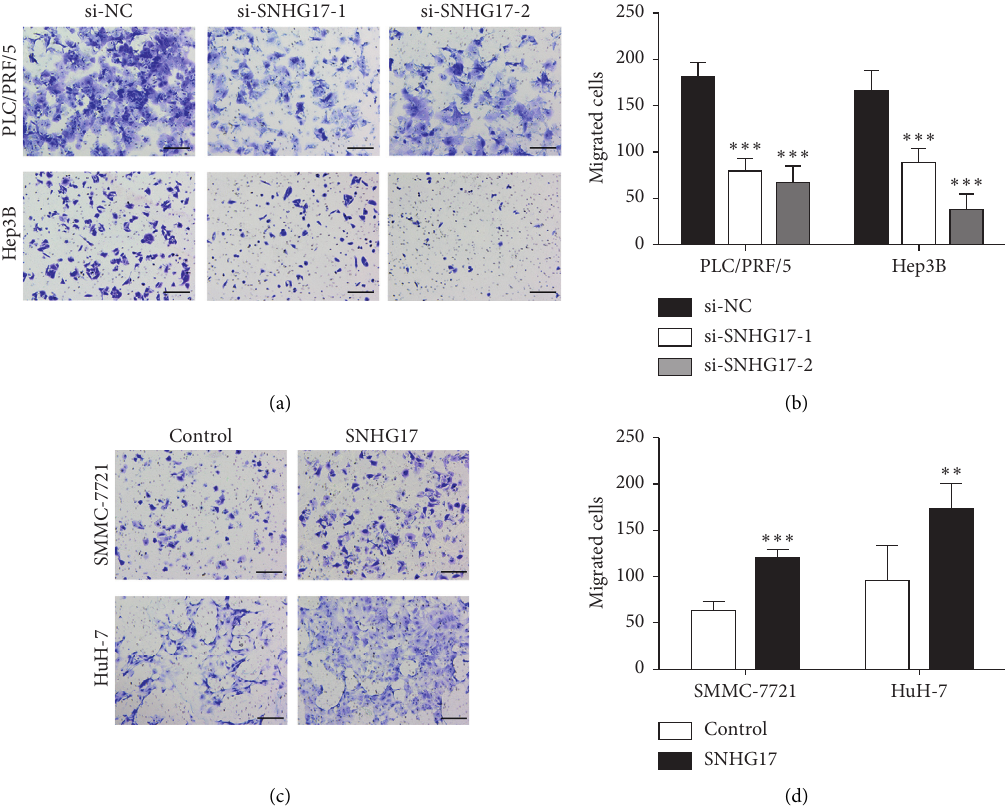
Figure 3: SNHG17 promoted cell migration of HCC. (a) The representative images of transwell assay in PLC/PRF/5 and Hep3B cells (magnification: 100X). (b) Quantitative data of transwell results in PLC/PRF/5 and Hep3B cells. (c) The representative images of transwell assay in SMMC-7721 and HuH-7 cells. Scale bar represents 200 pixels. (d) Quantitative data of transwell results in SMMC-7721 and HuH-7 cells. ∗∗ P < 0 . 01 and ∗∗∗ P < 0 . 001.